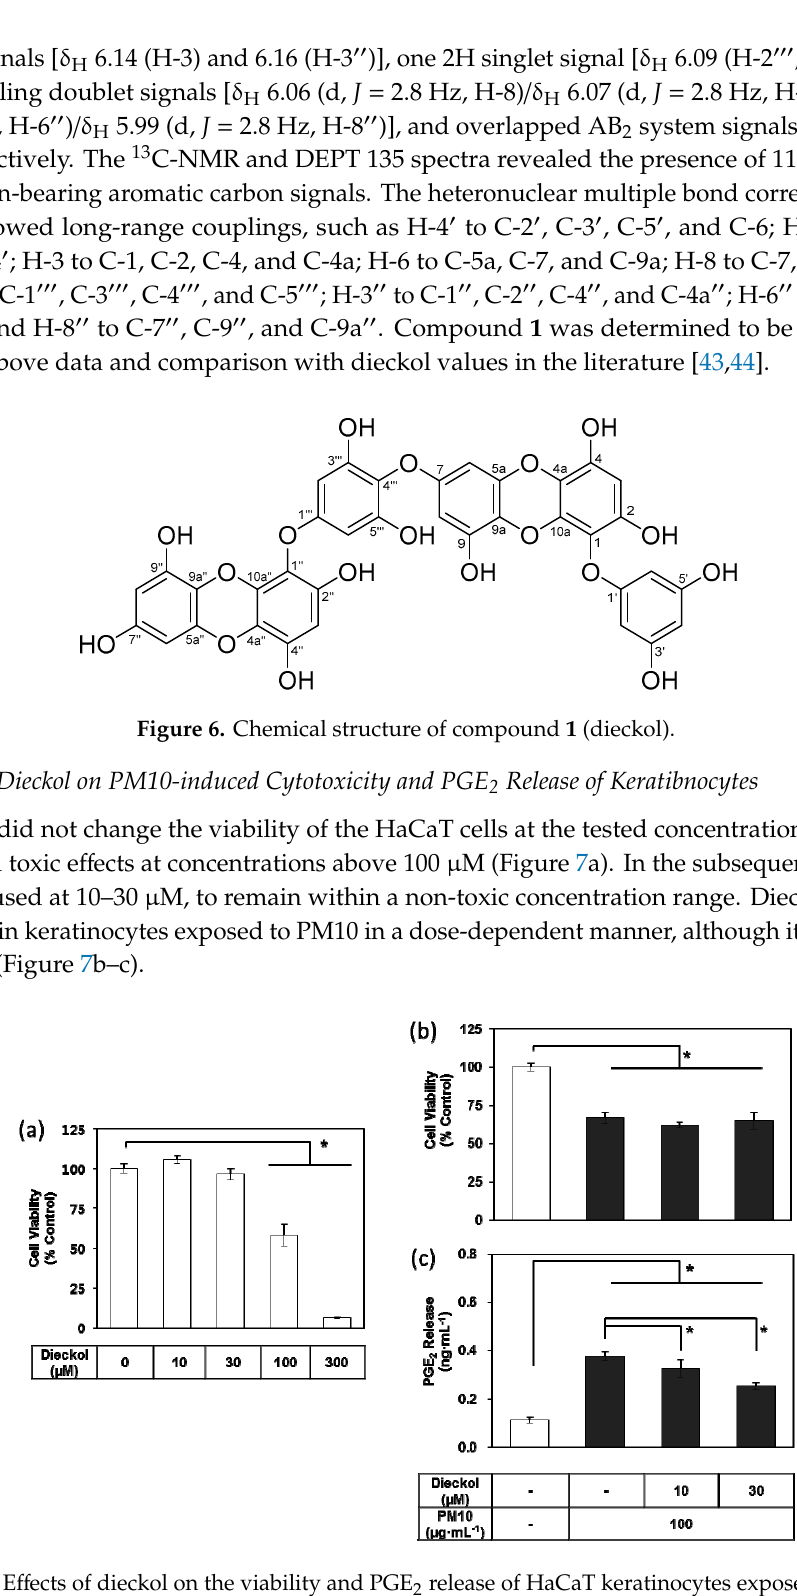
Figure 7. E ff ects of dieckol on the viability and PGE 2 release of HaCaT keratinocytes exposed to PM10. Cells were treated with dieckol at varied concentrations for 48 h for the viability assay ( a ). Cells were treated with 100 µ g mL − 1 PM10 in the presence or absence of dieckol at indicated concentrations